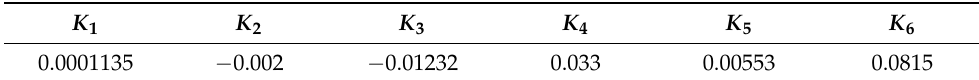
Table 3. Fitting coefficients of φ inlet .